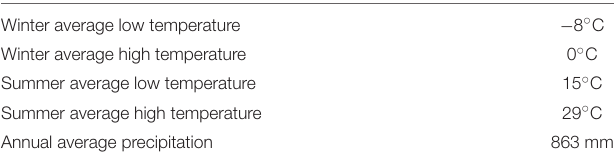
TABLE 1 | Long-term climate data for Adrian,